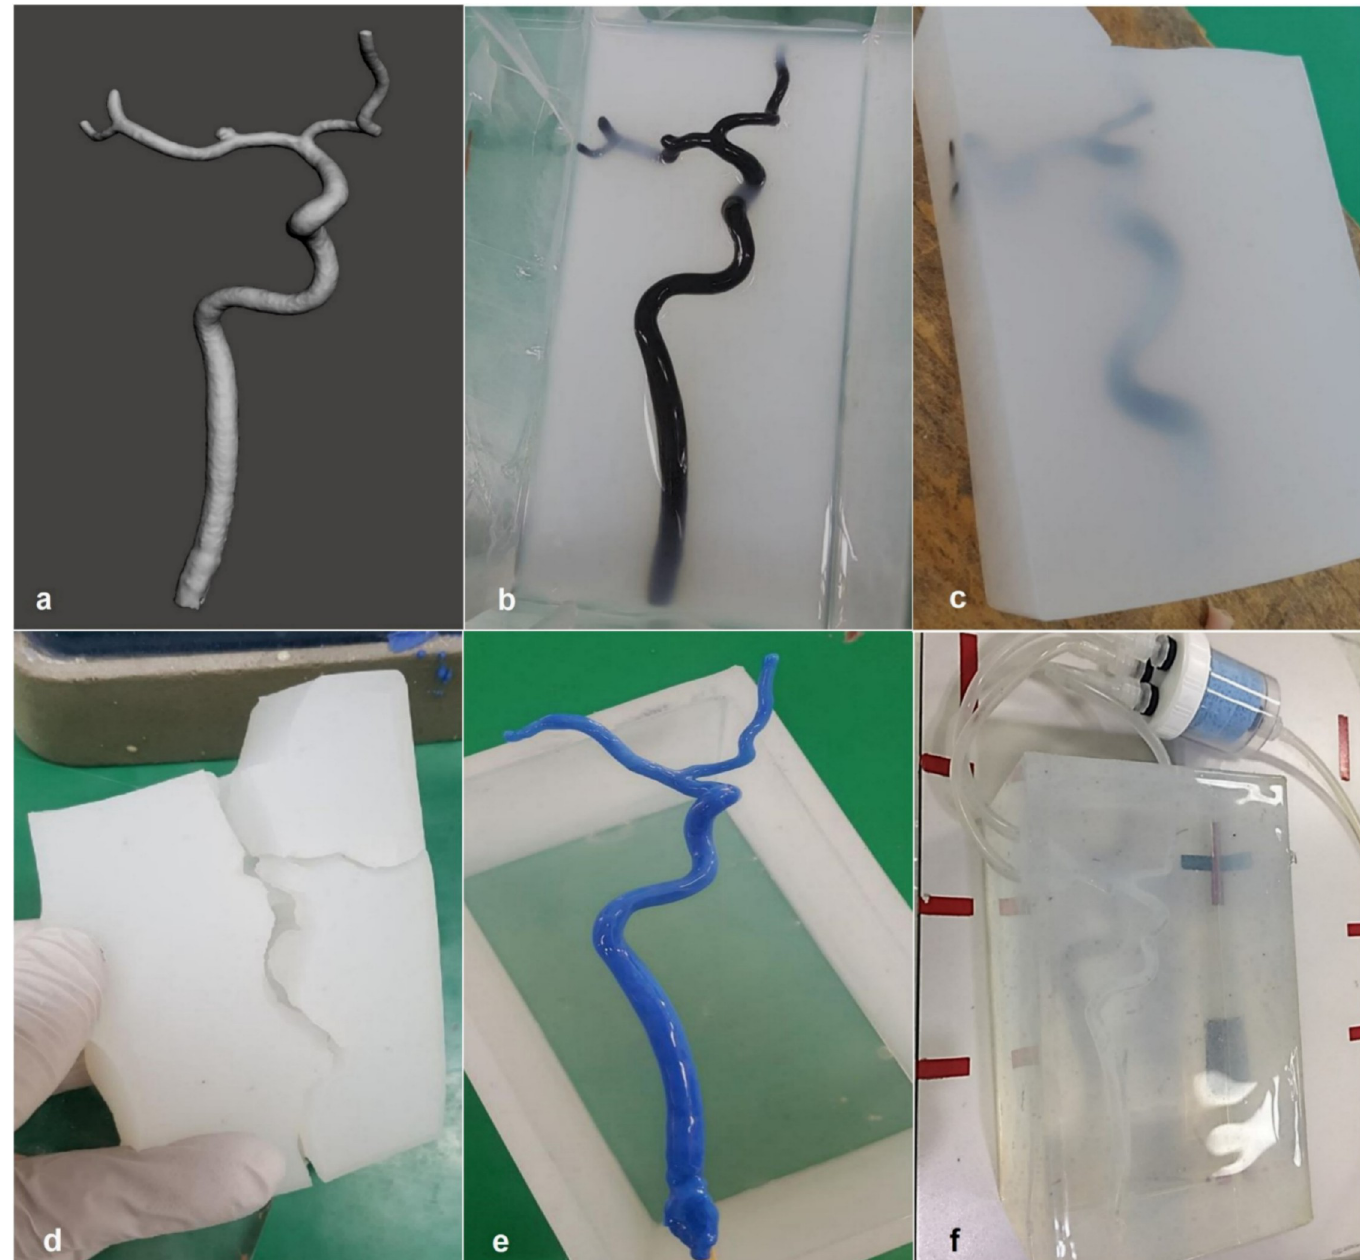
Fig 3. Cerebral arterial silicone phantom (CASP) used to replicate real contrast filling dynamics on cerebral angiography. (a) A three-dimensional (3D) vessel image in a stereolithography file format used for 3D printing. (b) A 3D-printed vascular acrylonitrile butadiene styrene copolymer model in a container containing liquid silicone. (c and d) Elimination of the surrounding silicone and extraction of the 3D-printed model. (e) The silicone-coated wax model was placed in rectangular silicone housing. (f) The resistance module of the fluid circulation CASP was composed of a plastic cistern and was filled with a sponge pad.